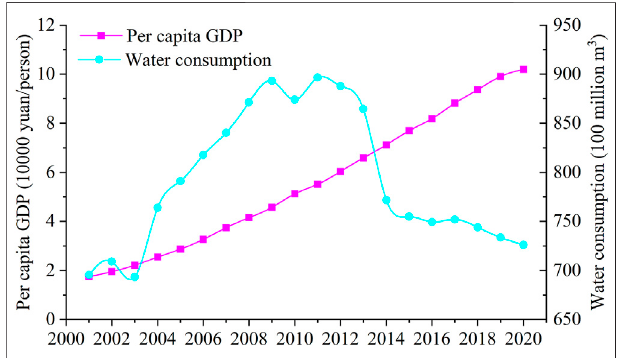
FIGURE 2 | Economic development and water consumption in the